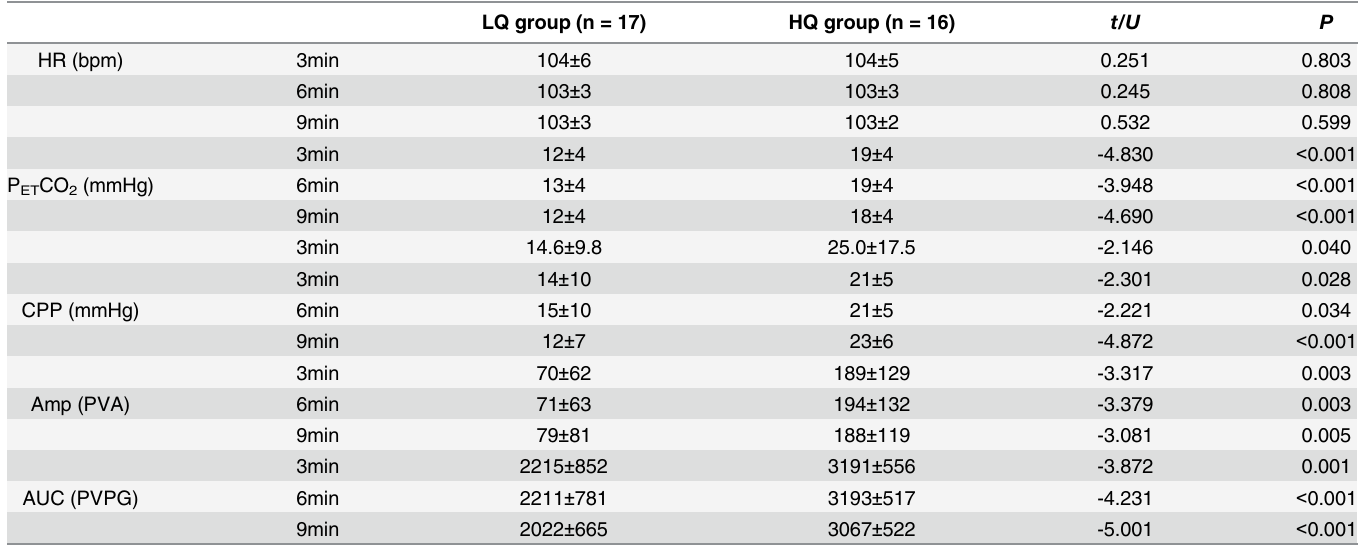
Table 2. Physiological parameters during